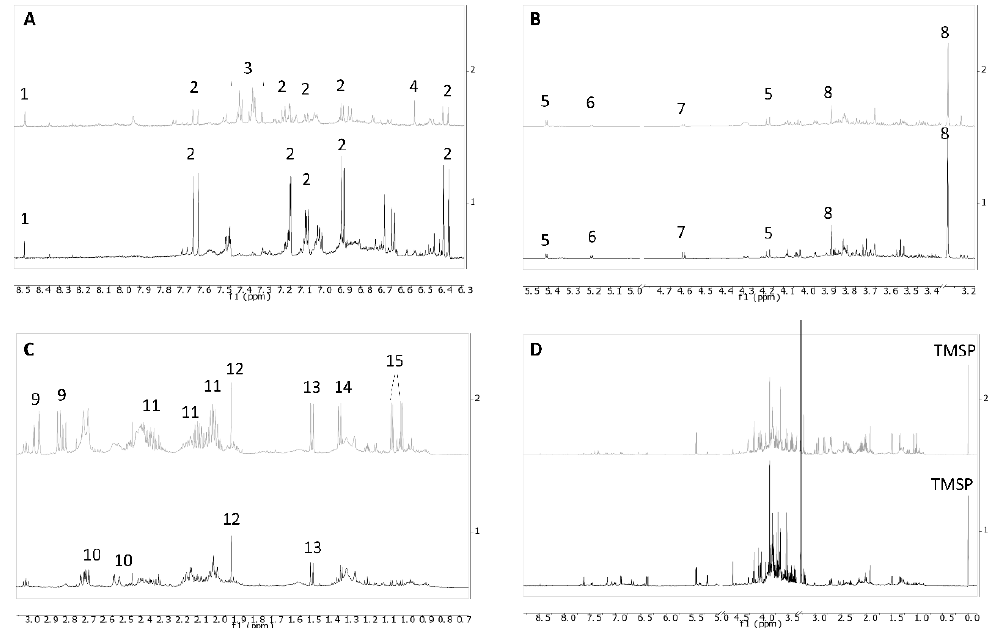
Figure 2. 1 H NMR profiles of representative samples harvested at 700 m a.s.l. (gray trace) and 100 m a.s.l. (black trace) on Stromboli. ( A ) Extended spectral region from δ 6.3 to 9; ( B ) region from δ 3.2 to 5.5; ( C ) region from δ 0.4 to 3.1; ( D ) full spectrum. Regions 4.78–4.98 and 3.30–3.35 were cut